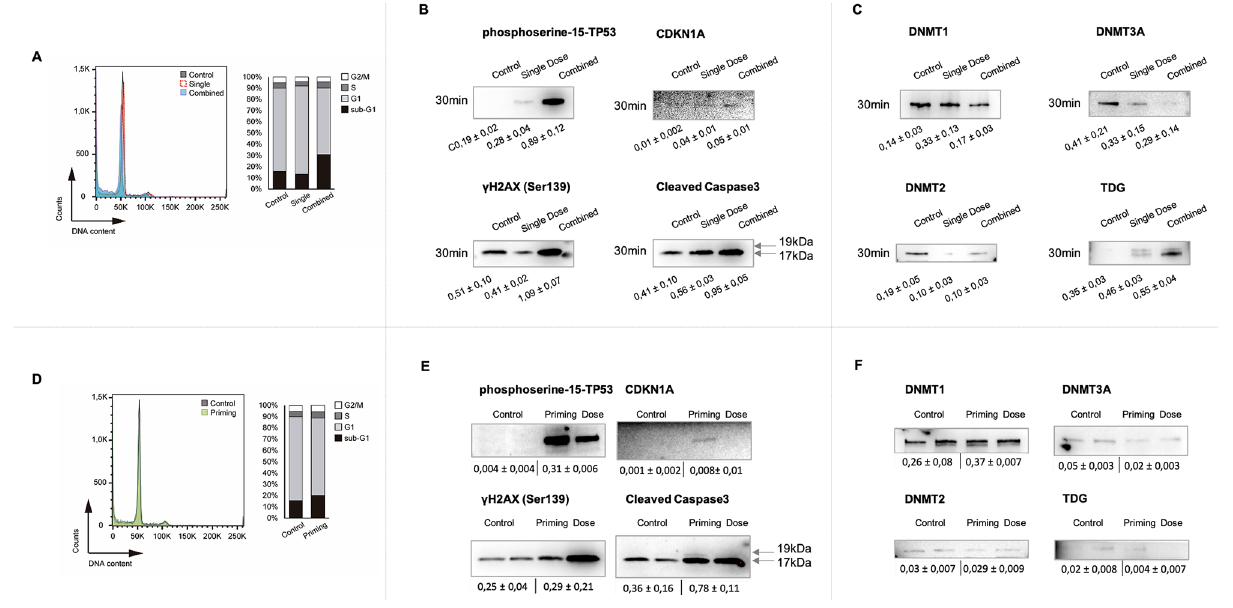
Figure 5. Ex vivo response to a combined regime in human thymocytes. ( A ) Cell cycle analysis using flow cytometry of human thymocytes exposed to radiation ex-vivo. Propidium iodide (PI) staining of thymocytes for each radiation regime; control cells, single dose (1.75 Gy) and combined regime (0.075 Gy + latency + 1.75 Gy) 30 min after exposure. Representative plot depicted in the left panel. The mean of 3 biological replicates is shown in the right panel. ( B ). Western blot analysis of several proteins of the ATM-TP53-phosphoserine-18-TP53 axis, damage response and cell death pathways in human thymocytes. Expression changes of phosphoserine- 15-TP53, p21 CDKN1A , γH2A.X-Ser139 (15 kDa) and caspase 3 activated subunits (19 and 17 kDa). Blots show 1 representative biological replicate. ( C ) Chromatin remodellers study in human thymocytes. Protein profiling of DNMT1 (200 kDa), DNMT2 (55 kDa), DNMT3A (130 kDa) and TDG (55–65 kDa) after the radiation treatment with either a single dose (1.75 Gy) or the combined regime (0.075 Gy + latency + 1.75 Gy) 30 min after exposure. Representative blots are presented. ( E ) Priming dose study in human thymocytes. Protein status of phosphoserine-15-TP53, p21 CDKN1A , γH2AX-Ser139 (15 kDa) and caspase 3 activated subunits (19 and 17 kDa) 6 h after the priming dose (0.0075 Gy). ( F ). Chromatin remodellers study 6 h after the priming dose in human thymocytes. Protein expression study of DNMT1, DNMT2, DNMT3A and TDG. Data shows 2 biological replicates for the control cells and 2 biological replicates for cells irradiated with the priming dose after a latency of 6 h. β-Actin was probed as a loading control for each membrane in annexed Fig. 5. Original blots are presented in supplementary